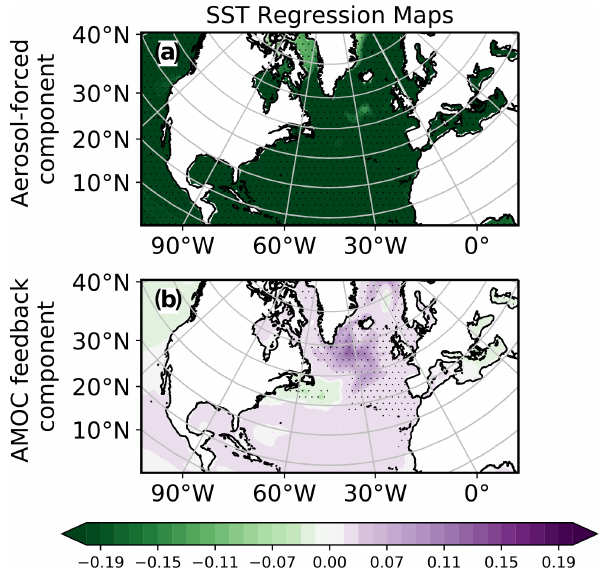
Figure 4. The 1940–2020 ensemble mean annual mean CMIP6 all forcing regression analysis: decomposition of sea surface tempera- ture (SST) into (a) aerosol-forced and (b) AMOC feedback com- ponents. The forced response is obtained by regressing the subpo- lar North Atlantic − 1 · SW time series (a proxy for anthropogenic aerosols) onto each field. The AMOC-related feedback is obtained by removing the variability associated with the forced response, and then regressing the AMOC time series onto this new field. The feedback field is converted to the same units as the aerosol-forced field by multiplying the feedback field by the regression slope be- tween the AMOC and − 1 · SW subpolar North Atlantic time series δ( AMOC ) = 0 . 32Sv ( Wm − 2 ) − 1 , significant at the 95% confidence δ( − 1 · SW ) level. The units for the SST regression maps are K ( Wm − 2 ) − 1 . Symbols denote regression significance at the 95% confidence